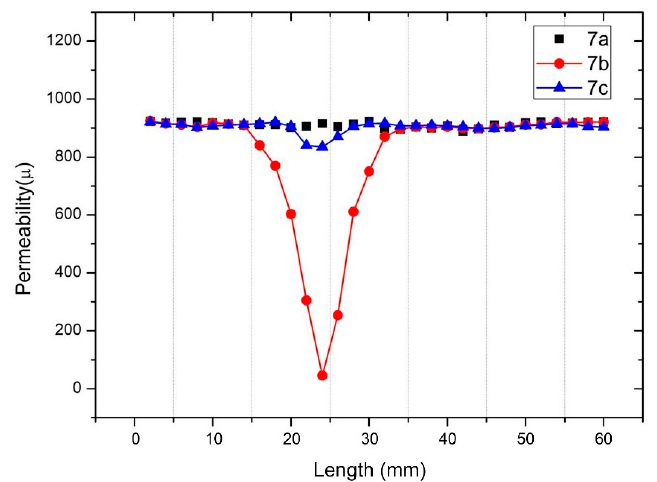
Figure 8. Permeability measurements along the AISI 1008 steel coupon correlated with residual stresses: ( a ) Initially monitored stress distribution in the stress relieved steel coupon (black points); ( b ) after beating the surface with the steel sphere; and ( c ) after localized heat treatment in the vicinity of the trace of the steel sphere. An improvement in the stress distribution of more than 90% can be observed.